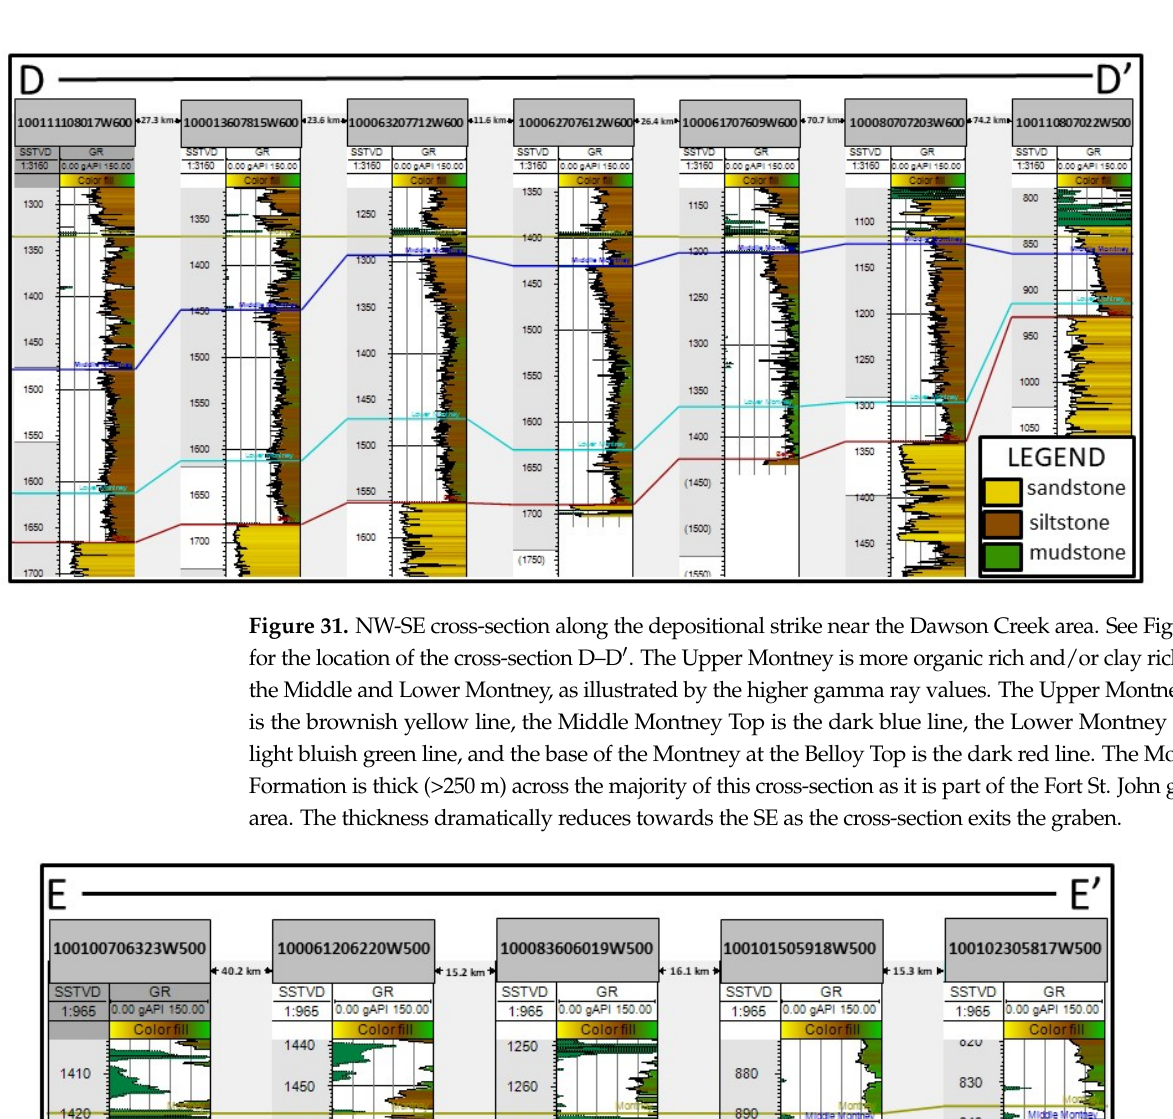
Figure 30. NE-SW cross-section along the depositional dip near the Dawson Creek area. See Figure 24 for the location of the cross-section C–C ′ . The Upper Montney Top is the brownish yellow line, the Middle Montney Top is the dark blue line, the Lower Montney Top is light bluish green line, and the base of the Montney at the Belloy Top is the dark red line. The Upper Montney subunit becomes thinner, and the overall gamma ray values for the Montney formation decrease towards the NE into Alberta.